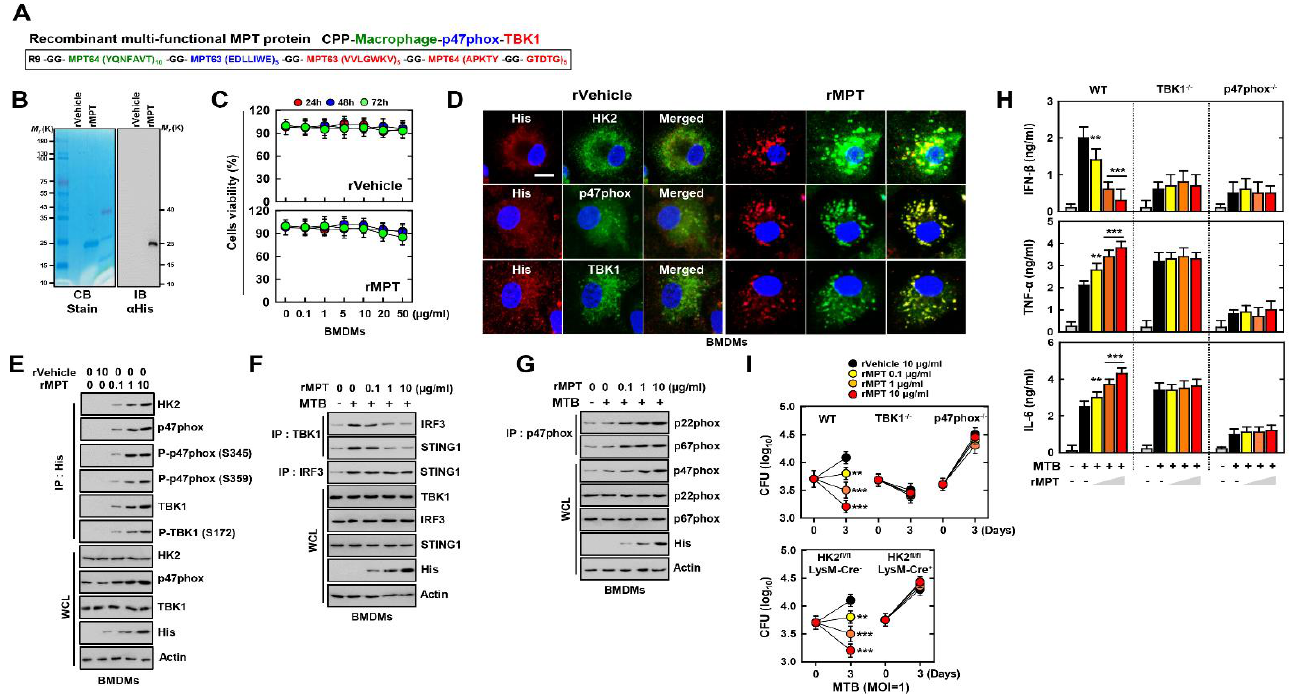
Figure 6. rMPT regulates MTB infection through enhancing the inflammation with declining the expression of IFN-β and increasing the level of ROS in macrophages. ( A ) Schematic in design of rMPT. ( B ) Bacterially purified 6xHis-rMPT and rVehicle were analyzed by coomassie blue staining (left) or immunoblotting (IB) with αHis (right). ( C ) BMDMs were incubated with rVehicle and rMPT for the indicated times and concentrations, then cell viability was measured with MTT assay. ( D ) BMDMs were treated with rVehicle or rMPT and immunolabelled with αHis (Alexa 586), αHK2, α p47phox, αTBK1 (Alexa 488), and DAPI. Scale bar, 10 µ m. ( E ) BMDMs were treated with rVehicle or rMPT for 1 h. BMDMs were used for IP by α His, followed by IB with α HK2, α p47phox, α P-p47phox (S345 and S359), α TBK1, α P-TBK1 (S172). WCLs were used for IB with α HK2, α p47phox, α TBK1, α His, and α Actin. ( F ) BMDMs were infected by MTB for 4 h and treated rMPT in various concentrations for 1 h. BMDMs were used for IP by α TBK1 and α IRF3, followed by IB with α IRF3 and α STING1. WCLs were used for IB with α TBK1, α IRF3, α STING1, α His, and α Actin. ( G ) BMDMs were used for IP by α p47phox, followed by IB with α p22phox and α p67phox. WCLs were used for IB with α p47phox, α p22phox, α p67phox, α His, and α Actin. ( H ) WT, TBK − / − , or p47phox − / − BMDMs were infected by MTB for 4 h and treated rMPT in various concentrations for 18 h. The supernatant of BMDMs were used for ELISA to measure the level of IFN- β , TNF- α , and IL-6. ( I ) The load of intracellular bacteria was measured after 3 d from treating the rVehicle or rMPT in WT, TBK − / − or p47phox − / − (Upper) and HK2 fl/fl LysM-Cre - , or HK2 fl/fl LysM-Cre + BMDMs. The data are representative of four independent experiments with similar results ( C – I ). Significant differences (* p < 0.05; ** p < 0.01; *** p < 0.001) compared with rVehicle-treated